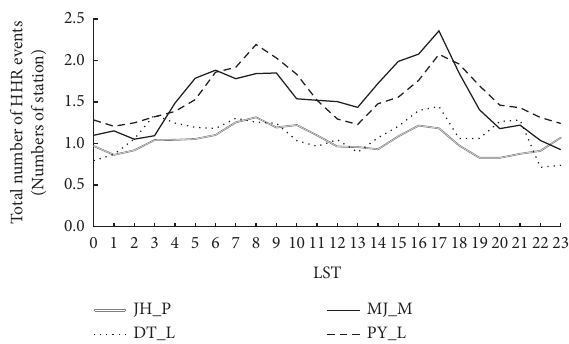
Figure 3: Diurnal variation of HHR event frequency over the four regions (JH_P, DT_L, MJ_M, and PY_L) around the TLB-YRV. Te ordinate axis represents the ratio between the total number of HHR events in the subregion and the number of stations in the subregion, and the abscissa axis represents hours in a